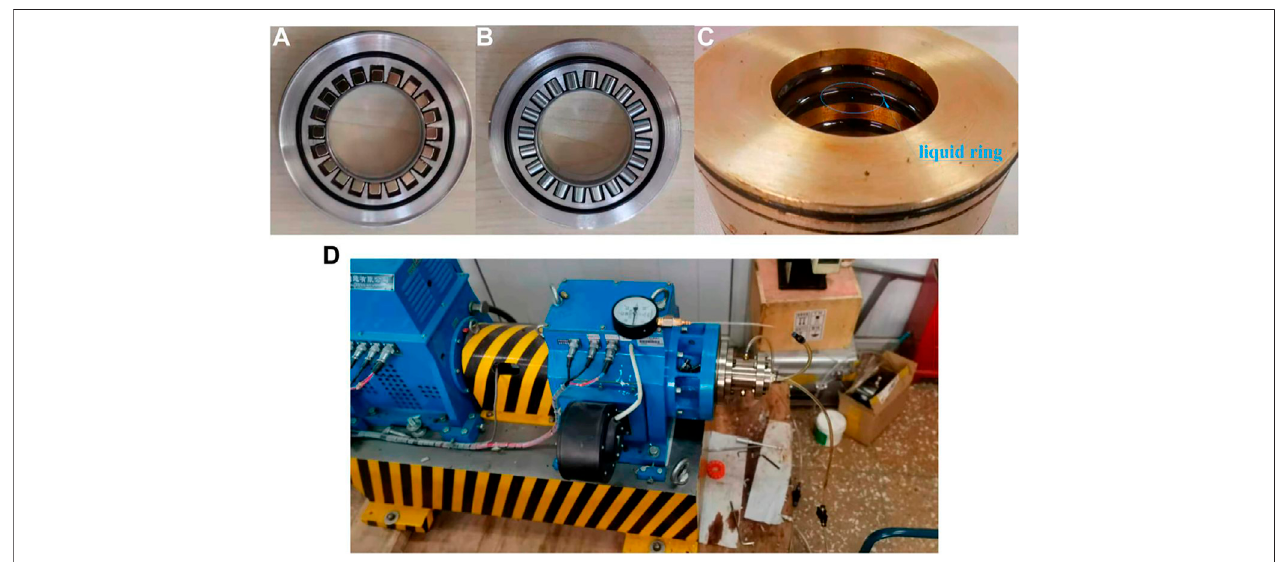
FIGURE 5 | Experimental device. (A) Cuboid magnets installed on nonmagnetic foundation; (B) cylindrical magnets installed on nonmagnetic foundation; (C) seal ring injected with FFs; (D) rotary seal experiment table.